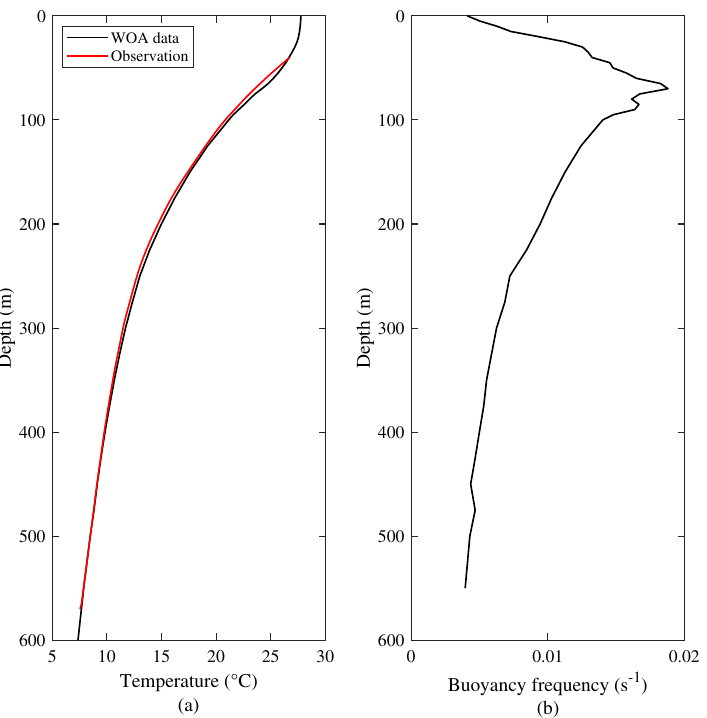
Figure 2. Vertical profiles of stratification. ( a ) Vertical profile of temperature from the WOA13 dataset (black curve) and measured temperature data (red curve). ( b ) Vertical profile of buoyancy frequency calculated with the WOA13